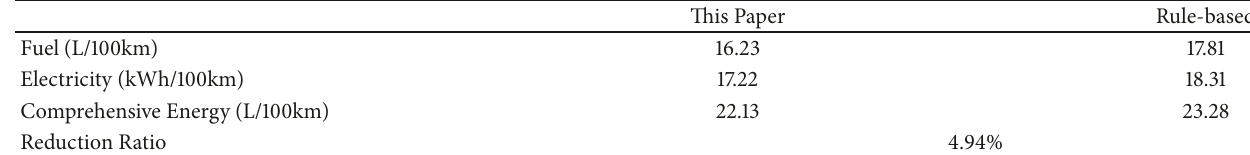
Table 11: Energy comparison of hardware in the loop test. This Paper